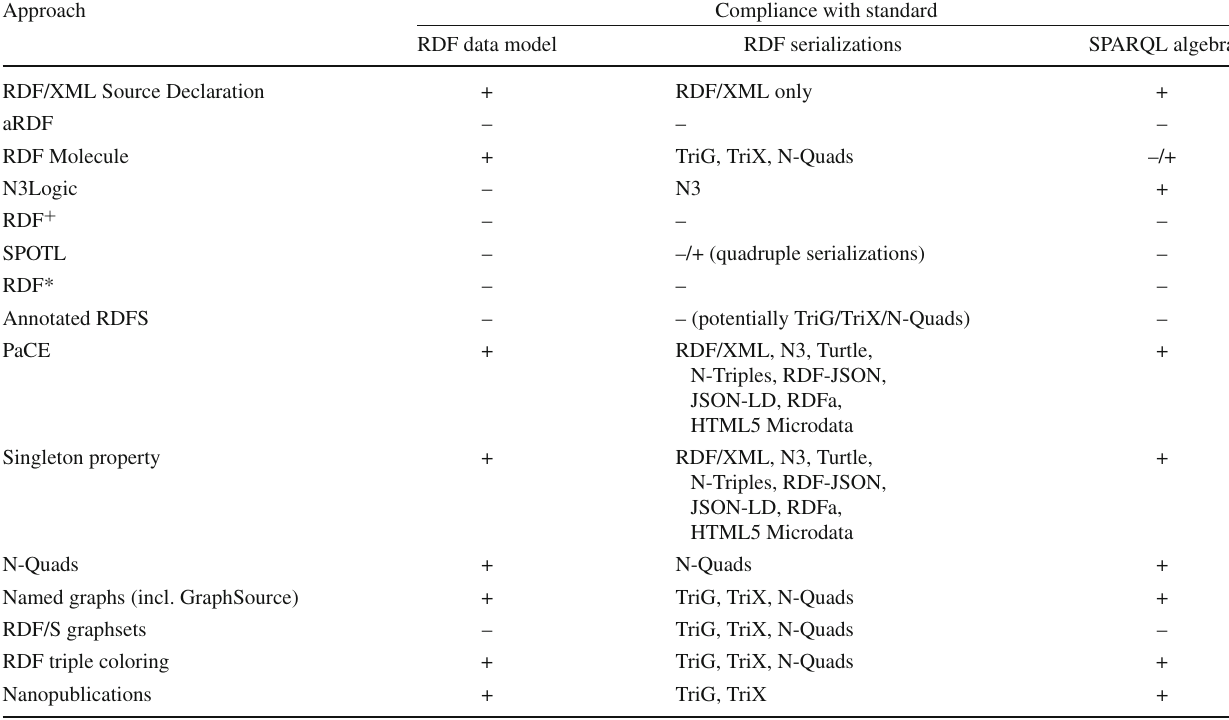
Table 5 Not all reification alternatives are standard-compliant Approach Compliance with standard RDF data model RDF